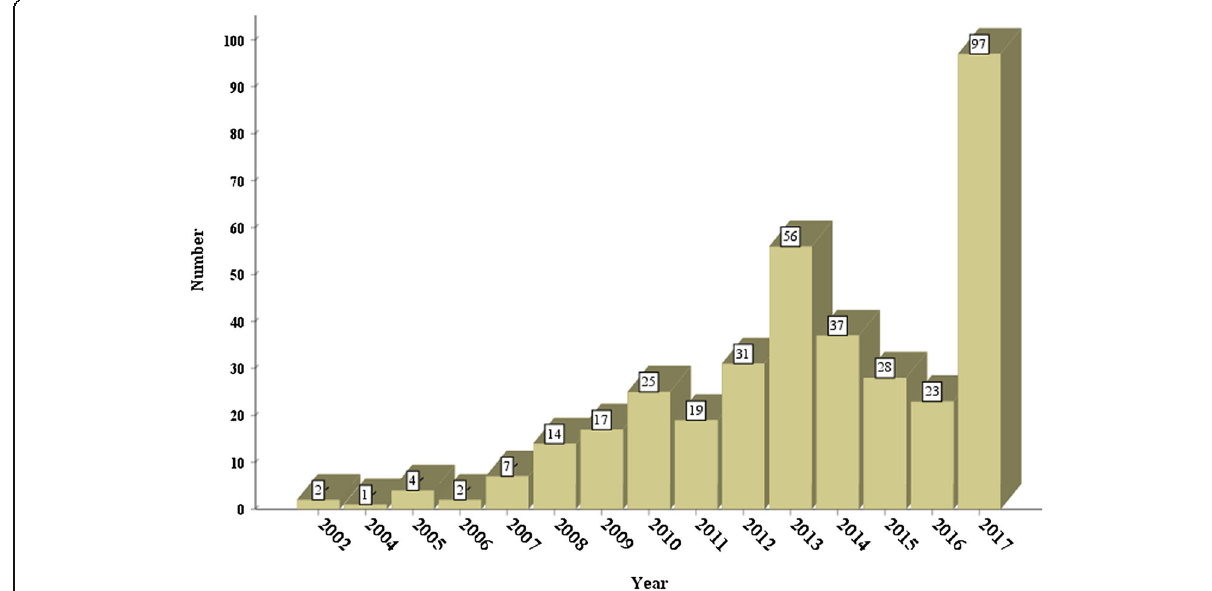
Fig. 2 Number of registered CHM-placebo controlled clinical trials from 2002 to 2017